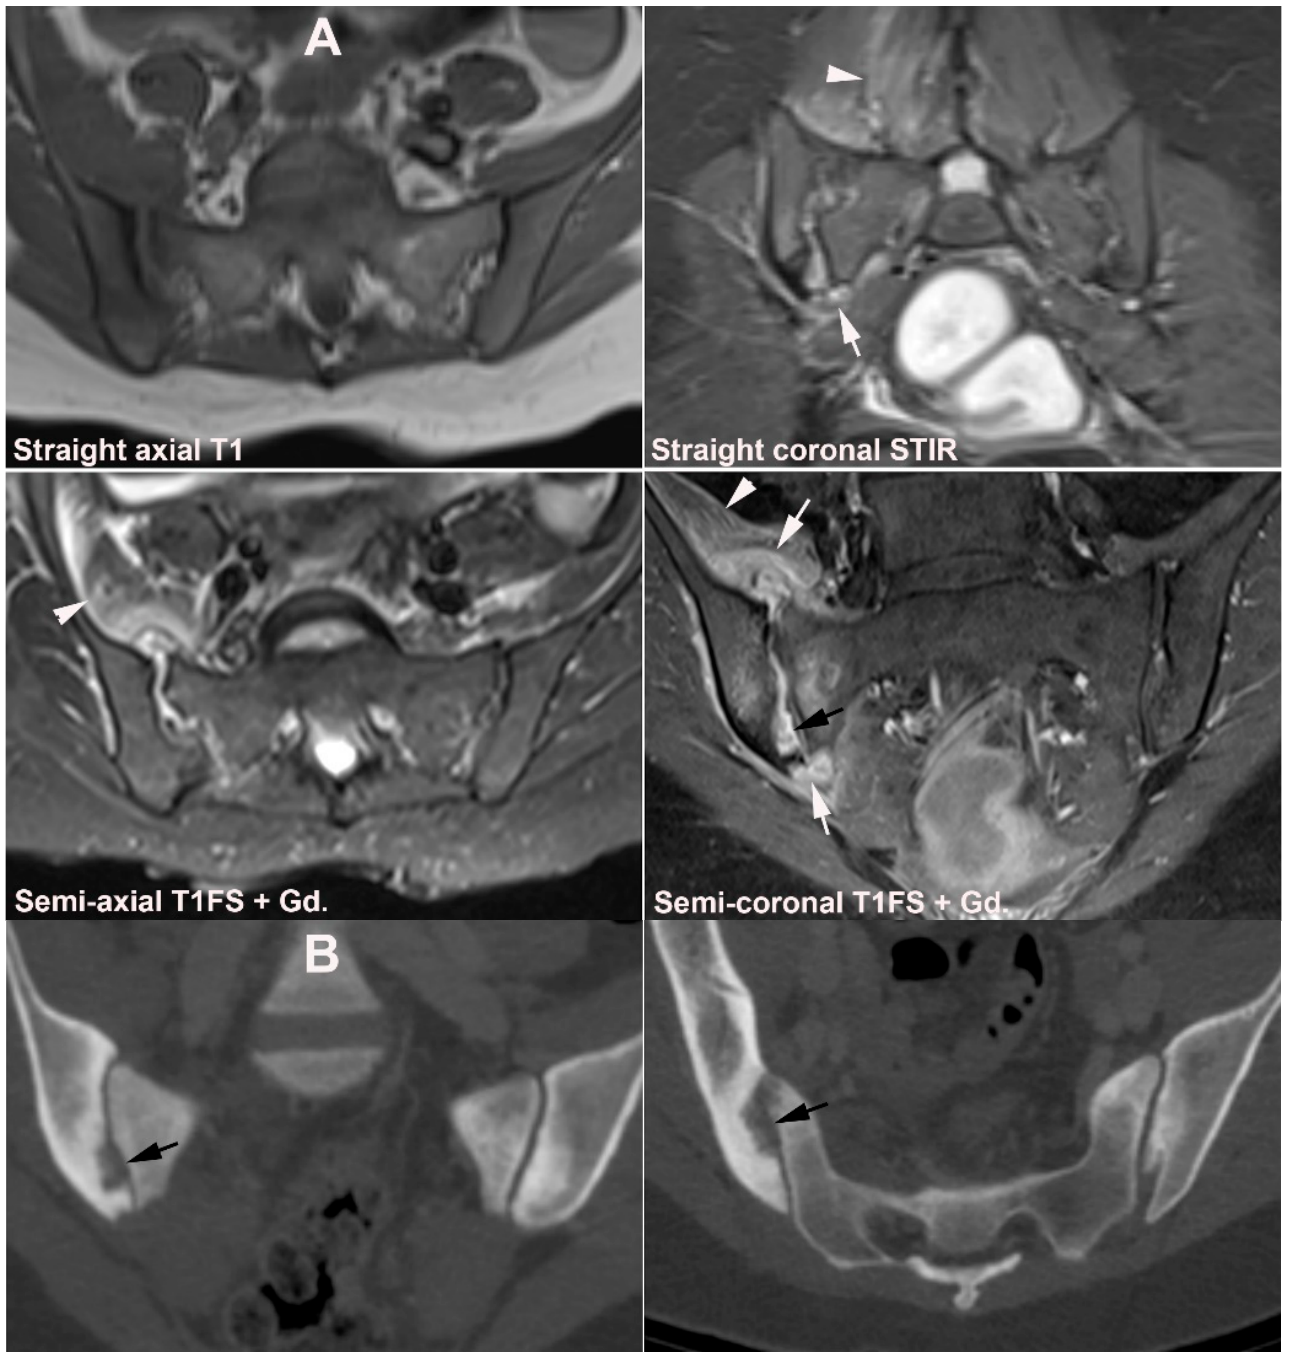
Figure 21. Infectious sacroiliitis. ( A ) MRI in a 30-year-old woman presenting with buttock pain for three weeks accompanied by malaise and fever, straight axial T1 and coronal STIR, and postcontrast semi-axial and semi-coronal T1FS. There are manifest edema and enhancement in the right joint space accompanied by subchondral edema and enhancement in addition to a thickened edematous and enhancing joint capsule (white arrows) and edema/enhancement in the surrounding soft tissue, especially in the right iliopsoas muscle (arrowheads). There seems to be an osseous defect inferiorly in the ileum (black arrow). ( B ) Supplementary CT, semi-coronal, and semi-axial reconstruction confirmed the presence of osseous destruction (black arrows), but no signs of osseous